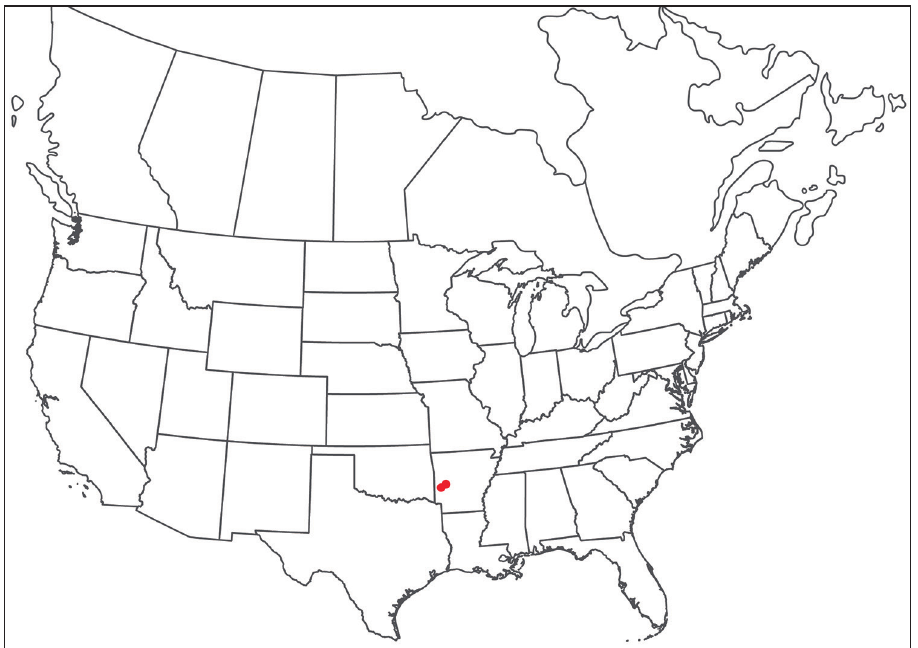
Figure 246. Torrenticola solisorta sp. n.